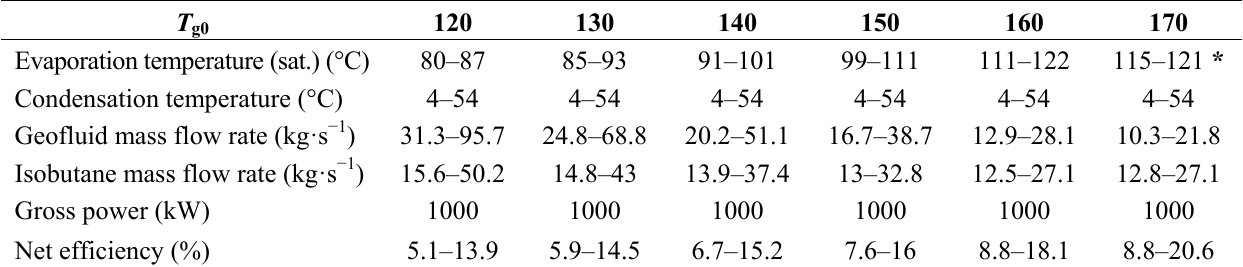
Table 2. Thermodynamic design of ORC cycles, showing range of optimal sizing results. T g0 Evaporation temperature (sat.)